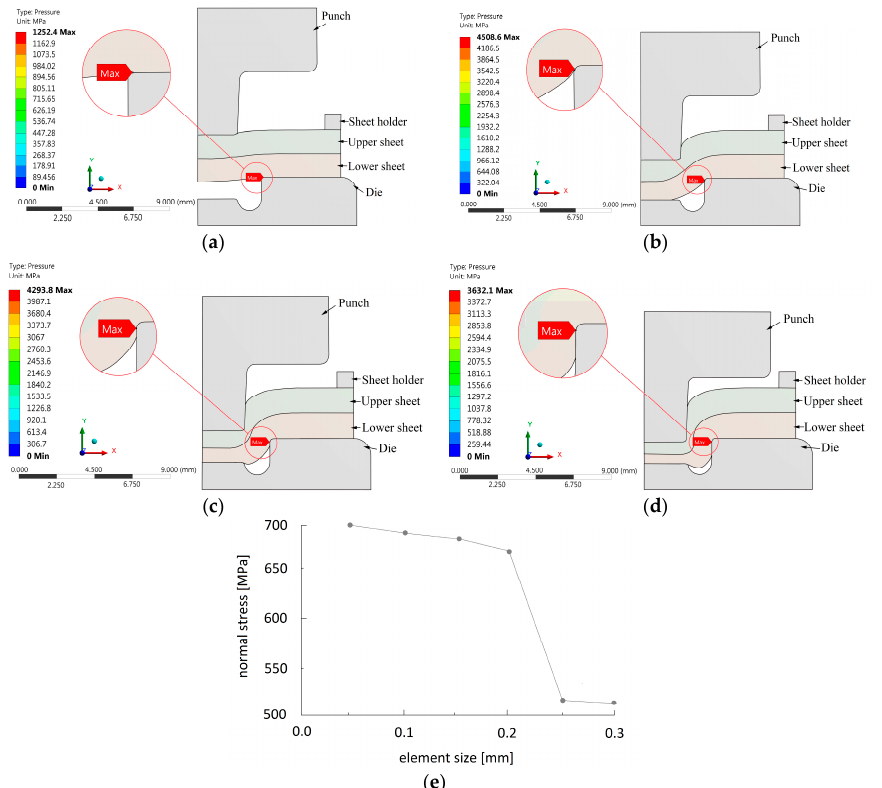
Figure 11. Clinching process: ( a ) maximum contact pressure during drawing; ( b ) maximum contact pressure during compression; ( c ) maximum contact pressure during interlocking; ( d ) maximum contact pressure during backward extrusion; ( e ) normal stress–element size mesh sensitivity.